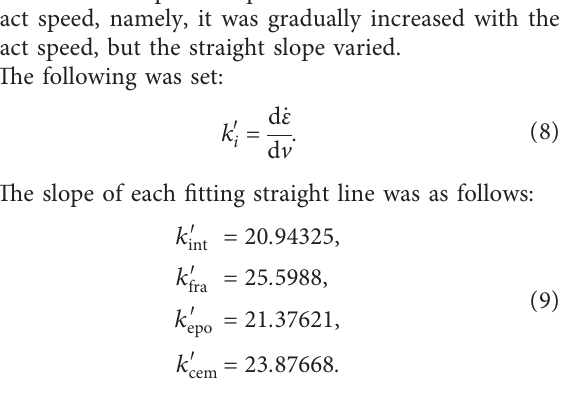
Table 2: Statistical table of specimen repair factor c